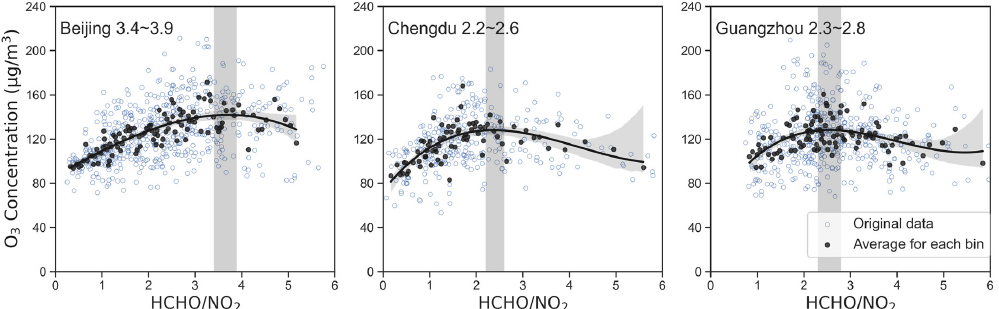
Figure 7. O 3 concentration as a function of HCHO / NO 2 for all sites in Beijing, Chengdu and Guangzhou. Black dots and lines are the same as those in Fig. 3b but divided into 100 bins, and blue circles are original